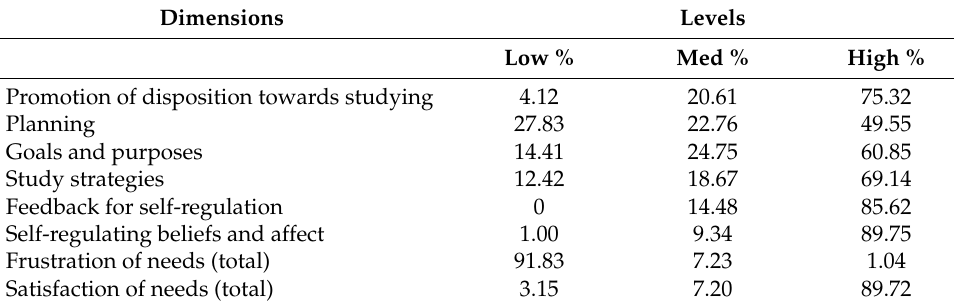
Table 3. Descriptive levels of the studied